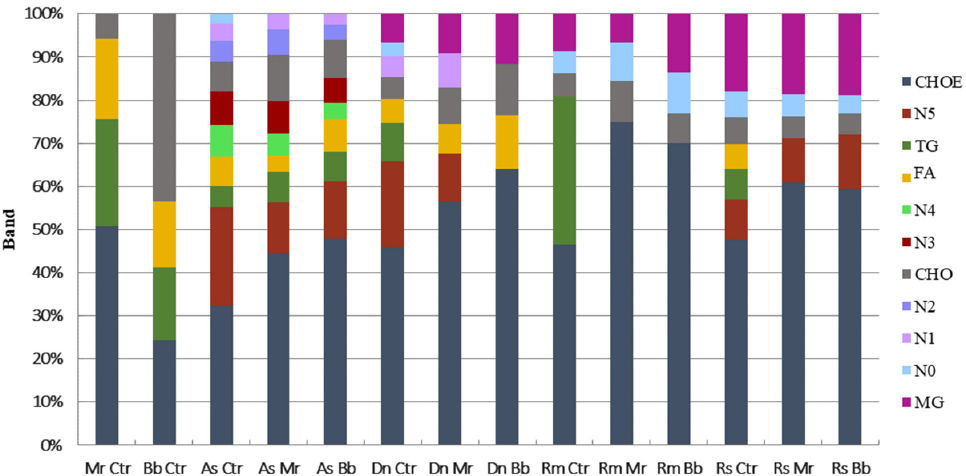
Figure 3. Electron micrographs of cuticles of Amblyomma sculptum (A and B), Dermacentor nitens (C and D), Rhipicephalus microplus (E and F) and Rhipicephalus sanguineus (G and H) at 24, 48 and 72 h after treatment with a conidial suspension of Metarhizium robertsii IP 146 (A, C, E and G) or Beauveria bassiana IIP 361 (B, D, F and H) at 5.0 × 10 8 conidia mL − 1 . C: conidium, GT: germ tube, AP: appresso- rium, scale bar: 5 µm.